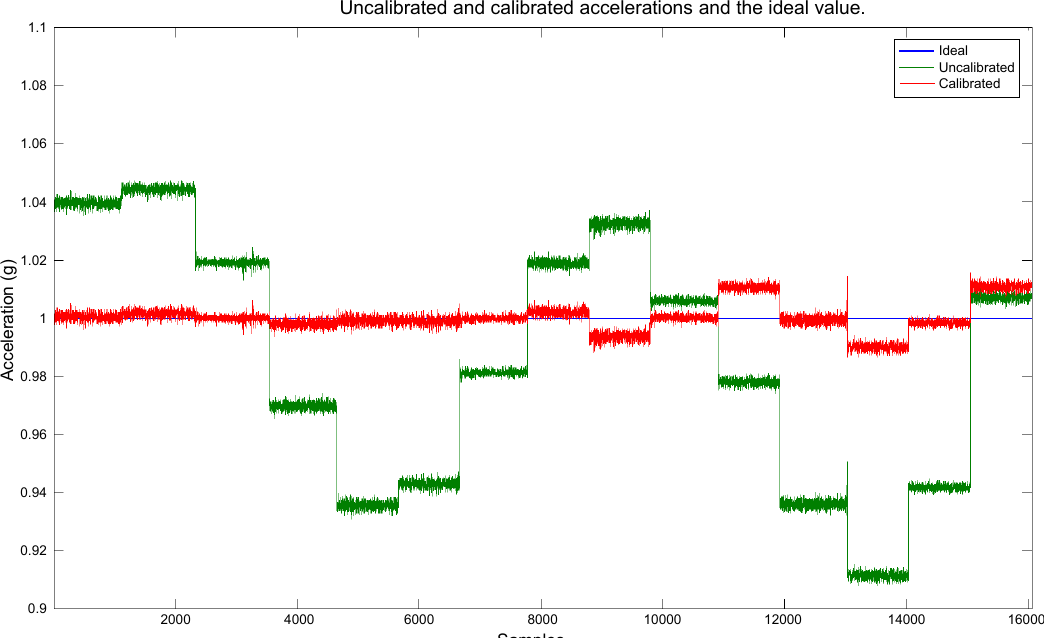
Figure 18. Comparative between the uncalibrated and calibrated data, and the ideal